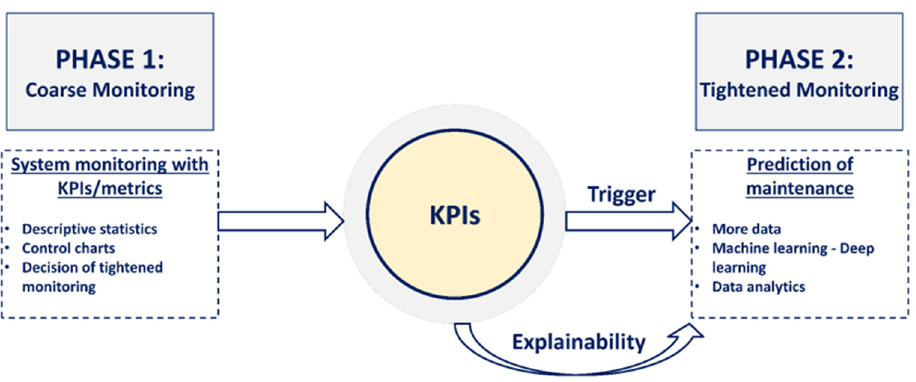
Figure 11. The phases of the monitoring process implemented the system. The coarse monitoring phase also includes the proposed system KPIs and metrics.